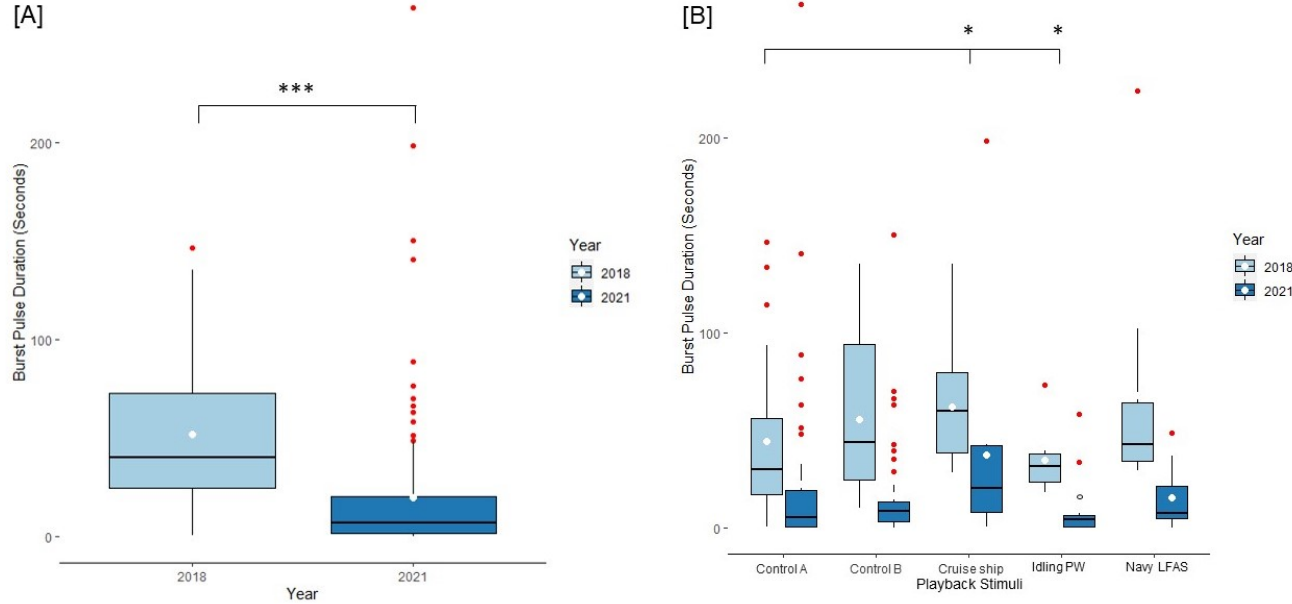
Figure 8. Burst Pulse bout Duration Reponses separated by fixed effect factors. ( A ) Box and whisker plot of decreases in burst pulse duration responses across the years 2018 and 2021. ( B ) Burst pulse duration responses grouped by year and playback type. * = p < 0.05, *** = p < 0.001. Means are denoted with white circles and the Idling personal watercraft is given with a black outline around the white circle. Outliers are denoted by red dots. Idling PW = idling personal